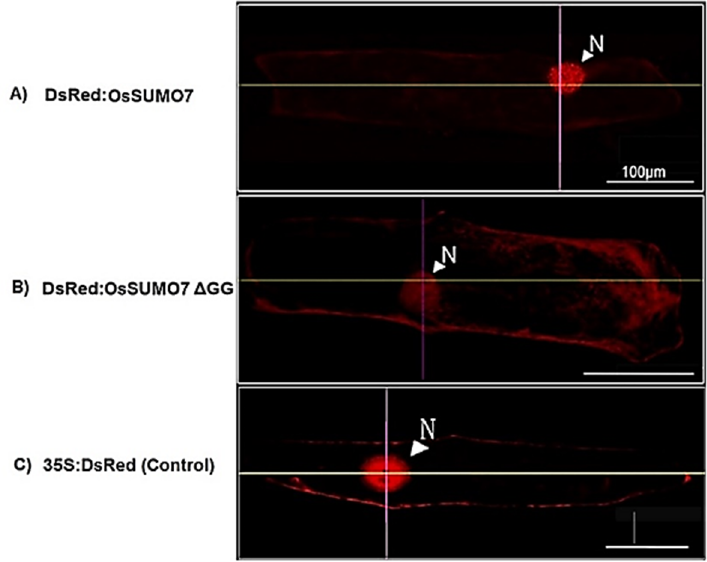
Figure 6. ( A ) Localization of DsRed:OsSUMO7 in onion cells. ( B ) Localization of DsRed:OsSUMO7 with GG deletion in onion cells. ( C ) 35S:DsRed (control).